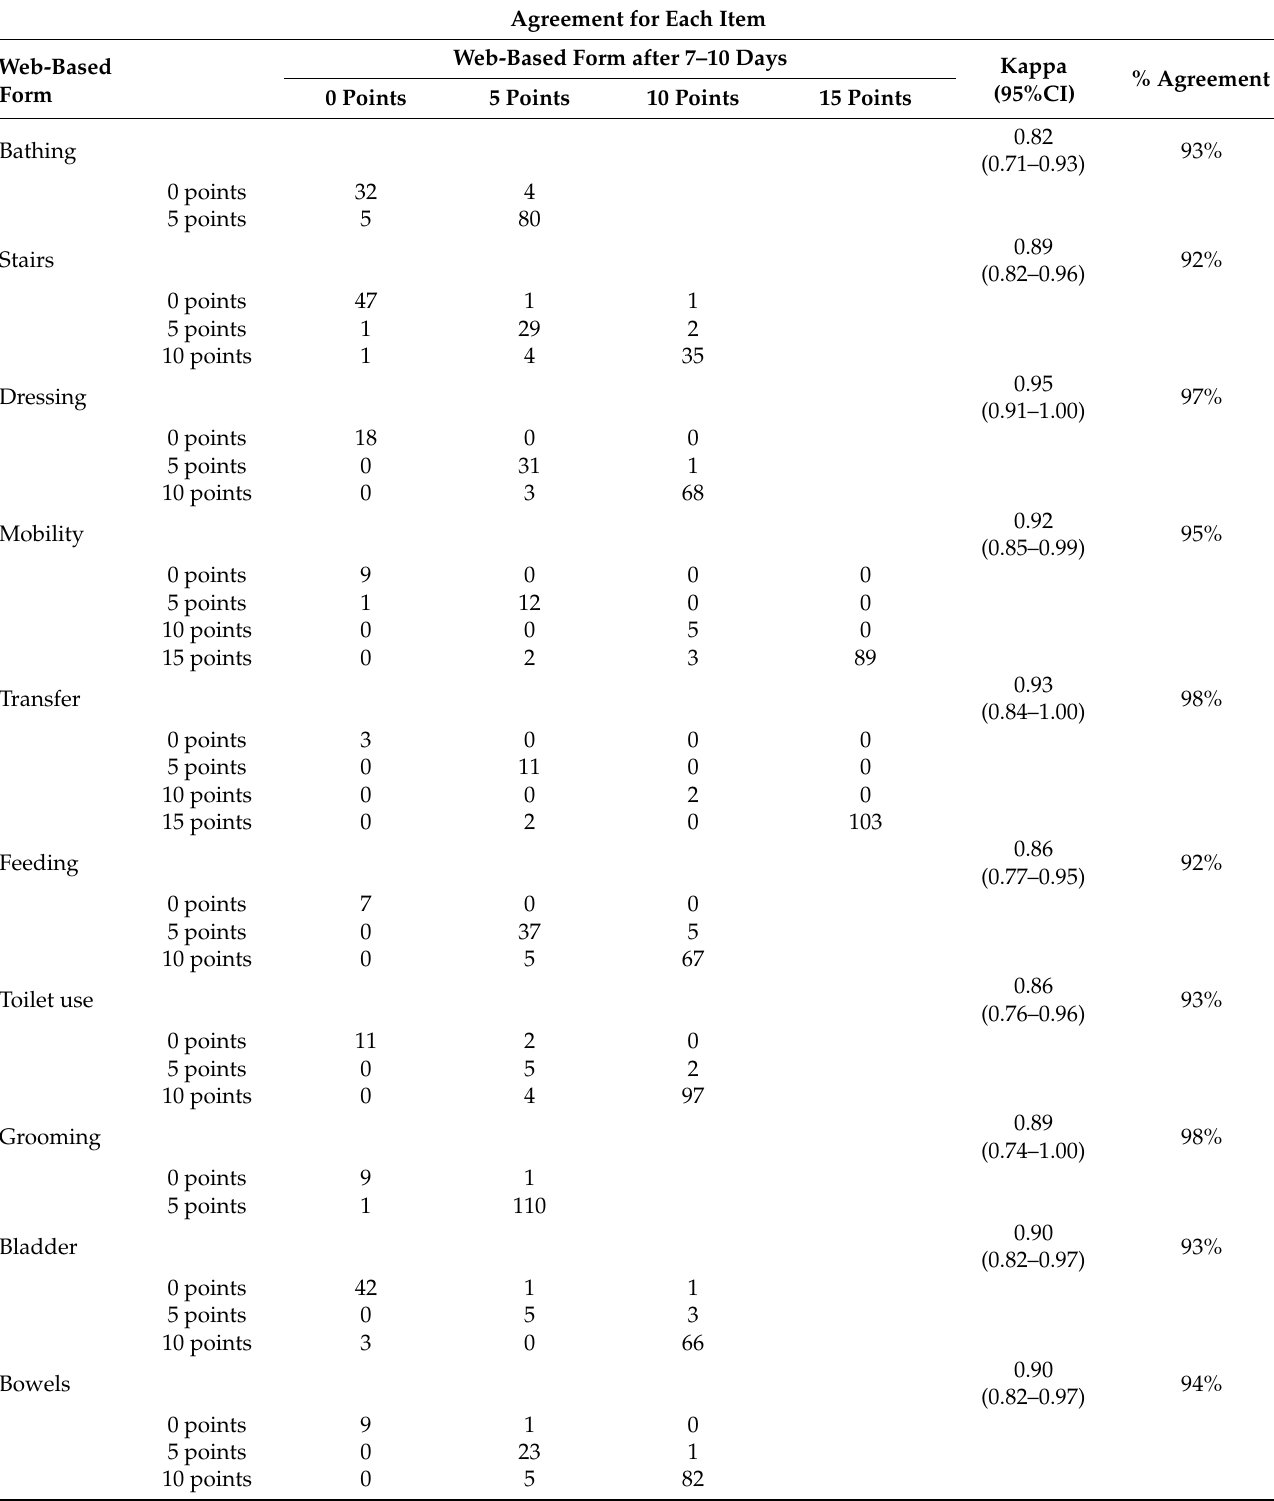
Table 5. Test-retest reliability for each item and for the total score of the categorical classification of the web-based form of the Barthel